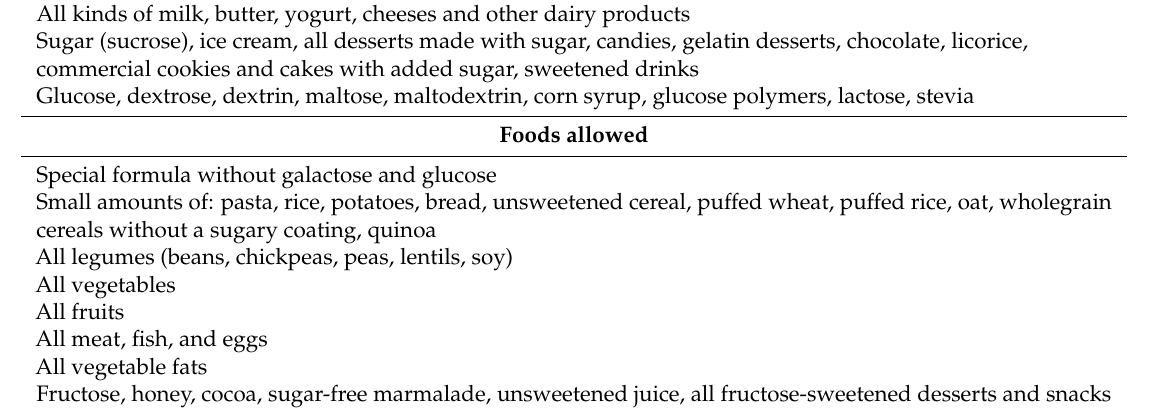
Table 2. Low glucose and galactose diet. Foods to